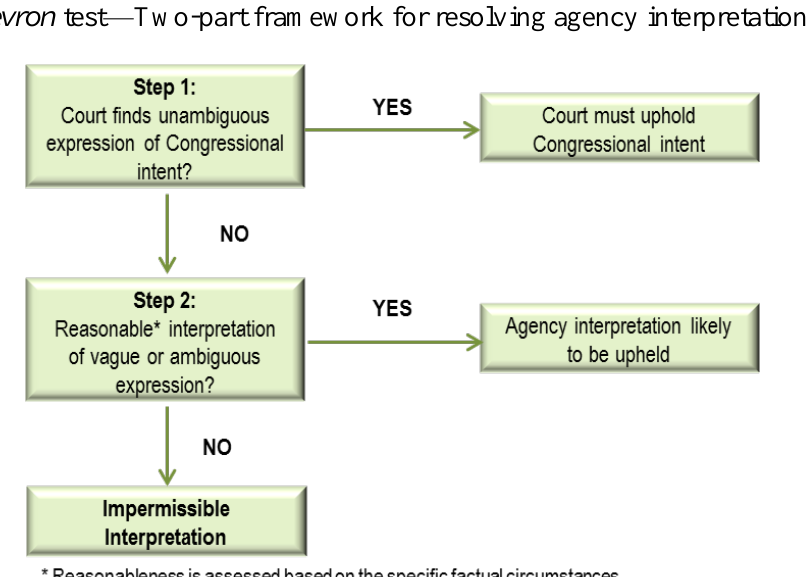
Figure 1. Chevron test—Two-part framework for resolving agency interpretations of